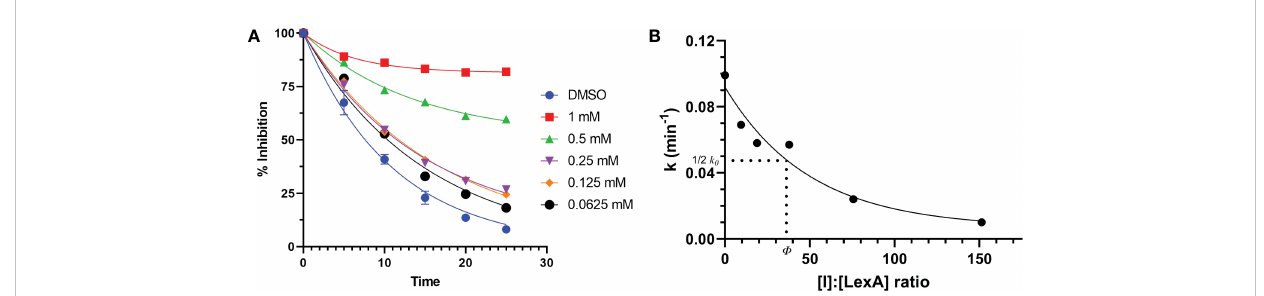
FIGURE 7 Time course of RecA-mediated LexA proteolysis in the presence of different concentrations of compound 1 (A) . Example gels are in Supplementary Material Figure S4. This was used to derive values of k for each concentration. The second graph (B) plots the values of k derived from graph (A) as a function of the [I]:[LexA] ratio. The value of f is the ratio that is half of the rate constant k 0